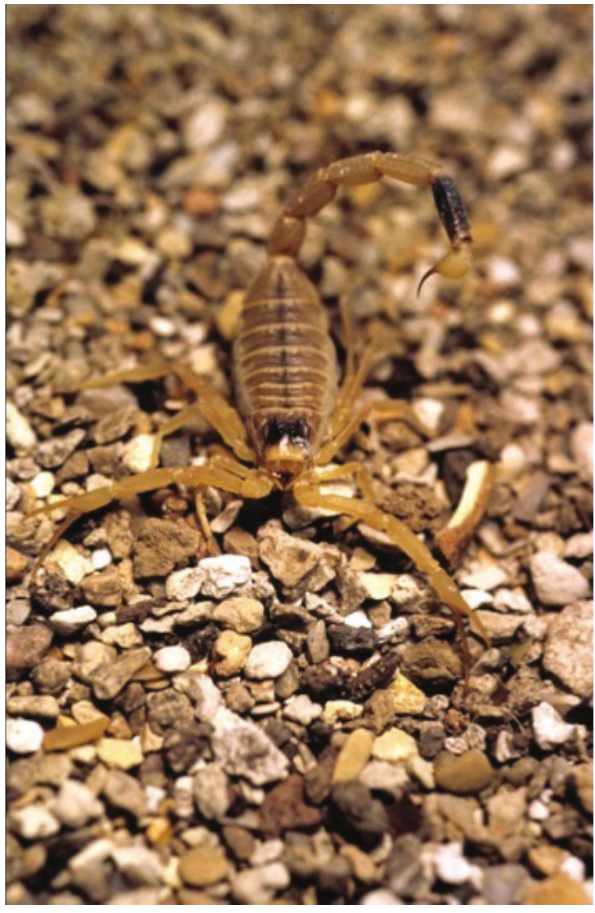
Figure 3 . Leiurus quinquestriatus , a scorpion species very dangerous for humans, frequently described in Saharan desertic zones, sometimes with Androctonus amoreuxi